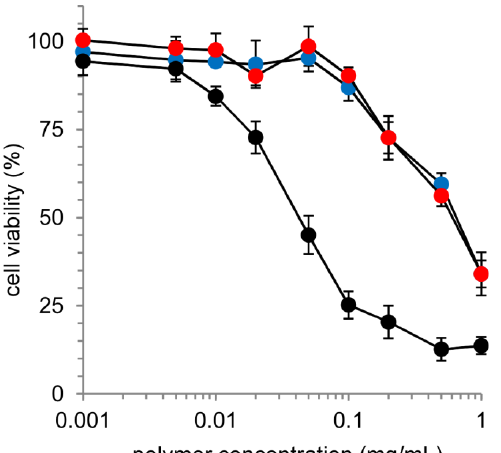
Cell viability was evaluated by an MTT assay. The cells (5 × 10 4 per well) were treated with the samples for 4 h, and were then cultured in a medium containing 10% FCS for 20 h. The data are presented as the average of three experiments ±